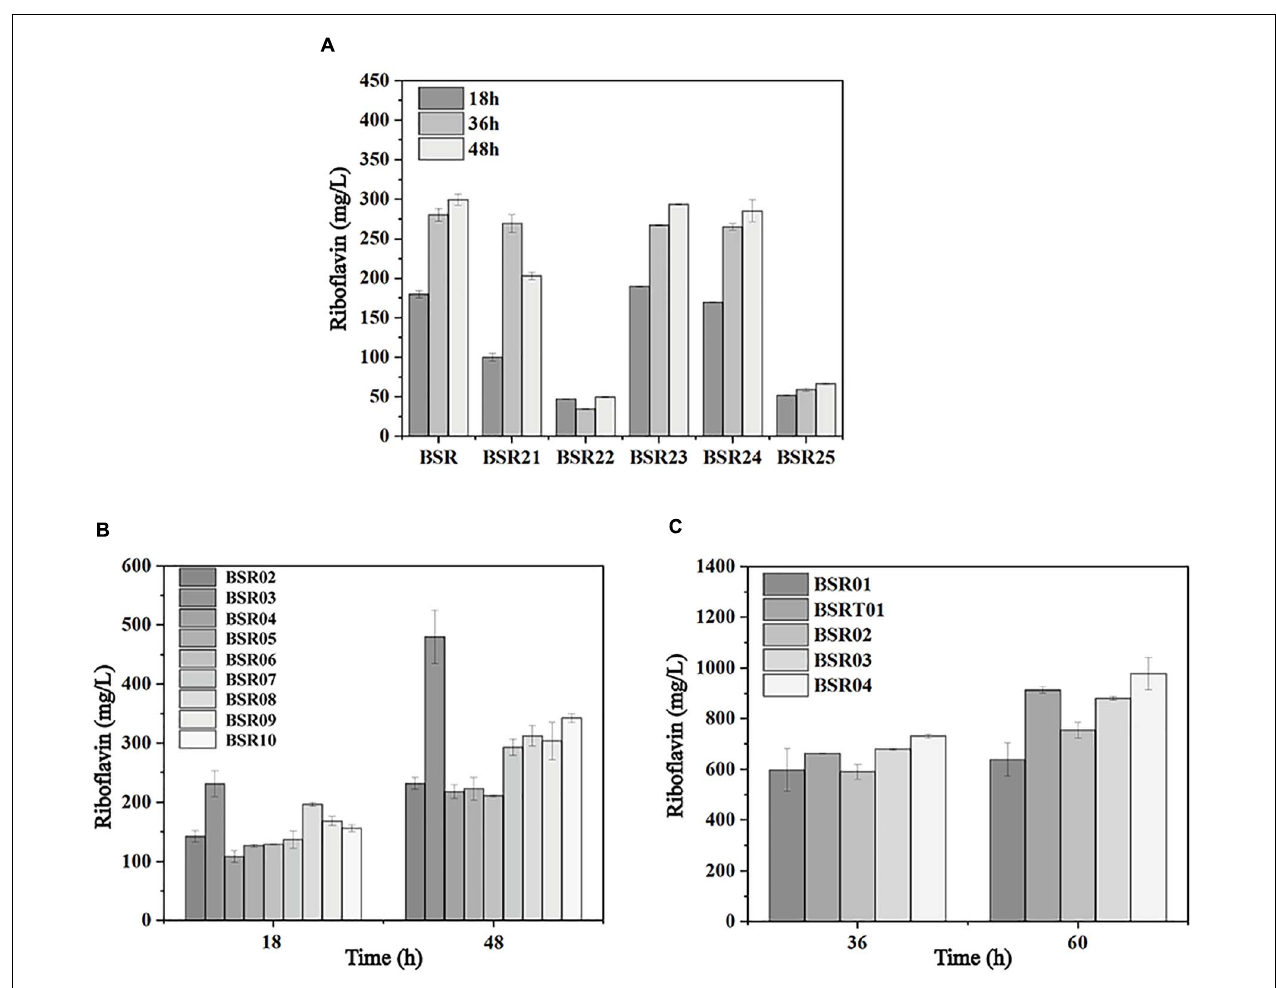
FIGURE 5 | Metabolic engineering of the initial producer strain harboring the rpe mutation to further enhance riboflavin production. (A) Comparison of riboflavin production in strains individually overexpressing the genes involved in the PPP, purine de novo synthesis pathway, and riboflavin biosynthesis pathway. (B) Comparison of riboflavin production in strains carrying deletions of genes involved in OPPP and their parent strain. (C) Comparison of riboflavin production in strains expressing the rib